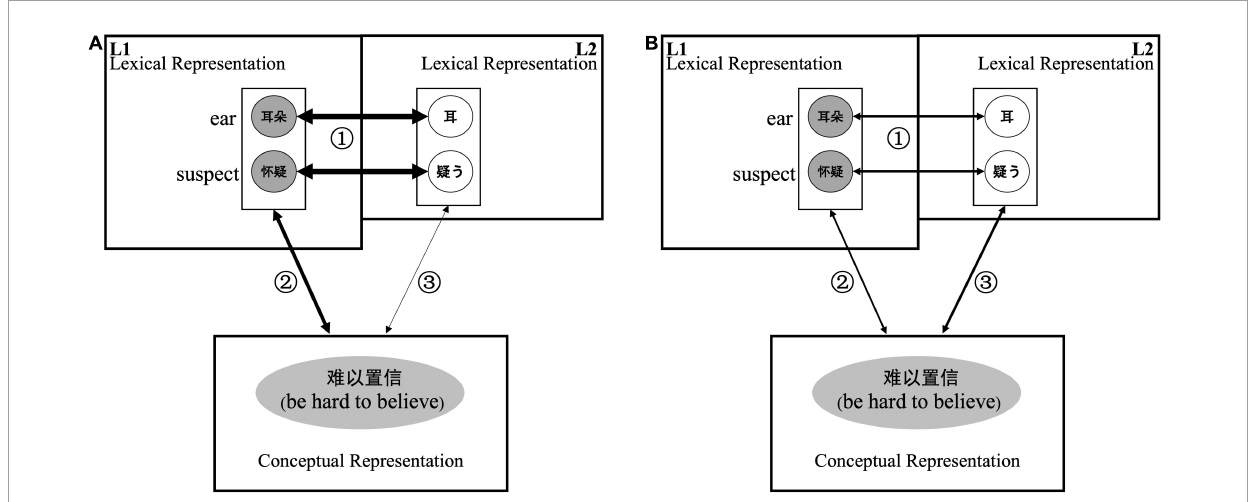
FIGURE6 Processing of a congruent translational collocation in Chinese JFL learners. The thickness of the arrows indicates the strength of the links between representations. (A) Represents the processing of congruent translational collocation upon visual presentation. (B) Represents the processing of congruent translational collocation upon auditory